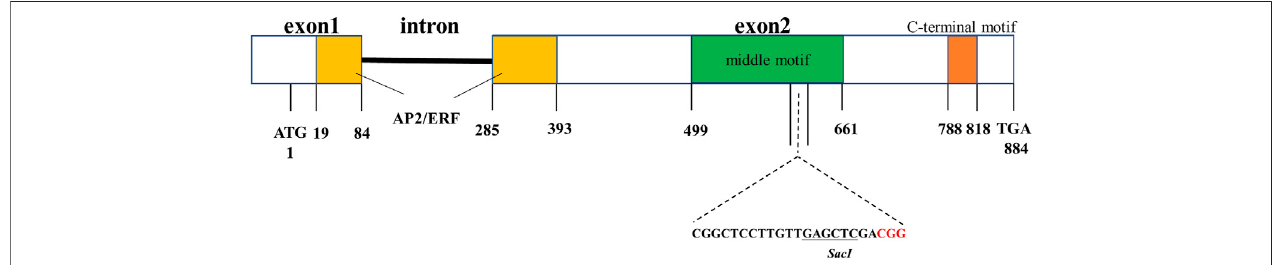
FIGURE 1 | Structure diagram of the HvNud gene. Boxes indicate exons, and the black bar between the boxes indicates intron.